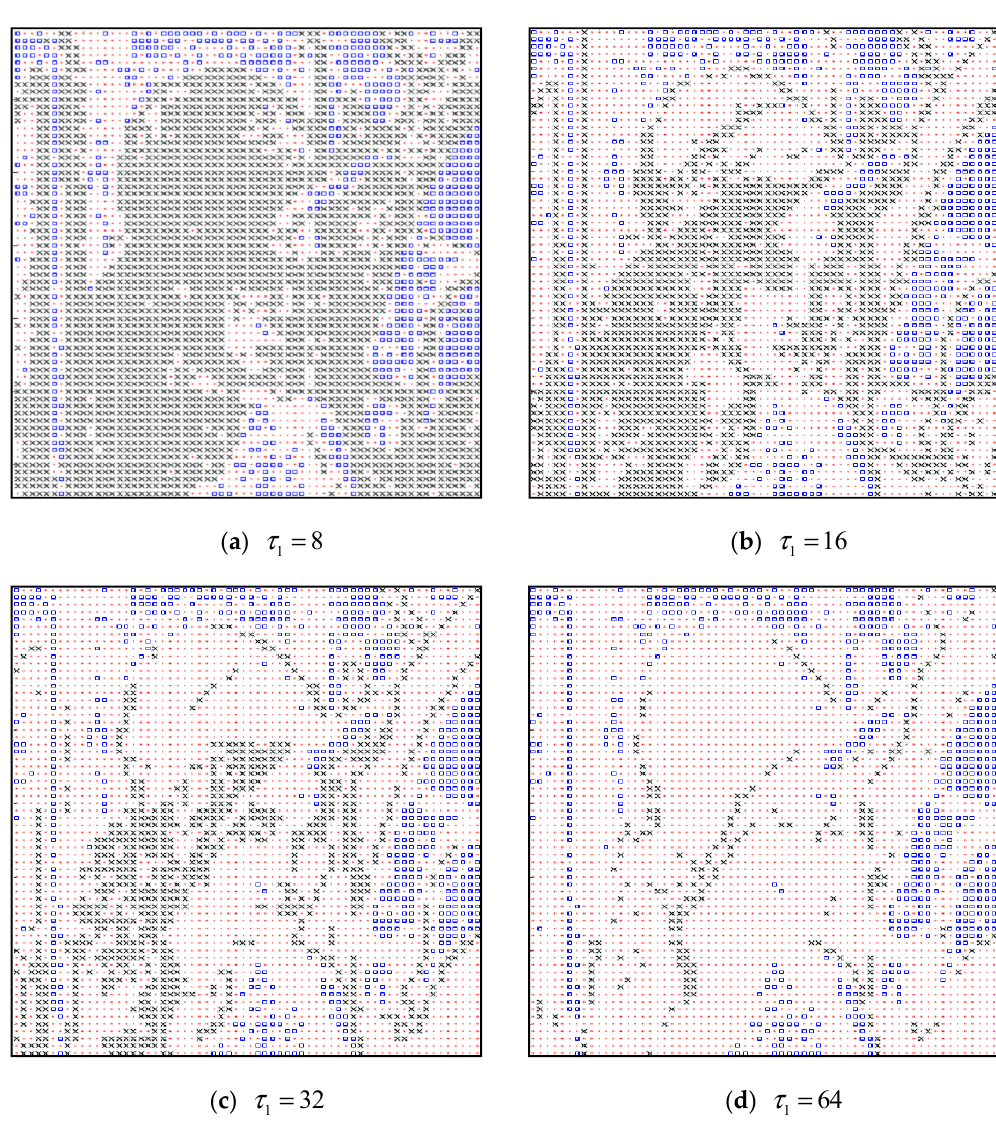
Figure 6. Distribution of flat, smooth and complex blocks.